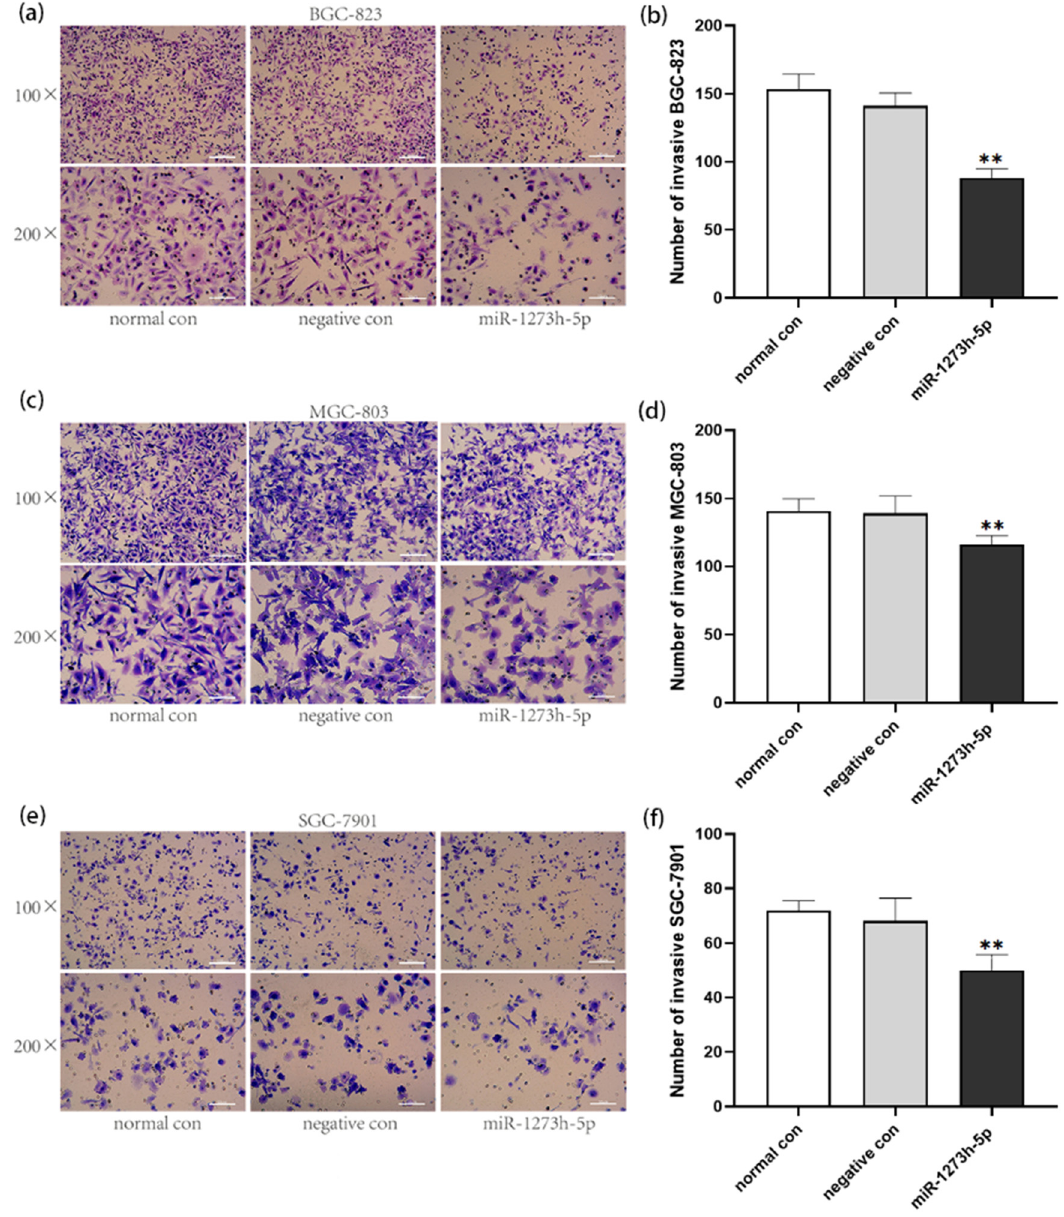
Figure 5: E ff ect of miR - 1273h - 5p on GC cell invasion. ( a and b ) E ff ect of miR - 1273h - 5p on the invasion of BGC - 823 cells at 24 h after transfection determined by transwell assay. ( c and d ) Impact of miR - 1273h - 5p on the invasion of MGC - 803 cells at 24 h after transfection determined by transwell assay. ( e and f ) Impact of miR - 1273h - 5p on the invasion of SGC - 7901 cells at 24 h after transfection determined using transwell assay. The miR - 1273h - 5p group had a signi fi cant decrease in contrast with the negative group in three cell models. Pictures of each group included two kinds of speci fi cations with 200 × used for statistics. Scale bars have been depicted. All data were expressed as M ± SD from three independent experiments compared with the negative control group, ** P <